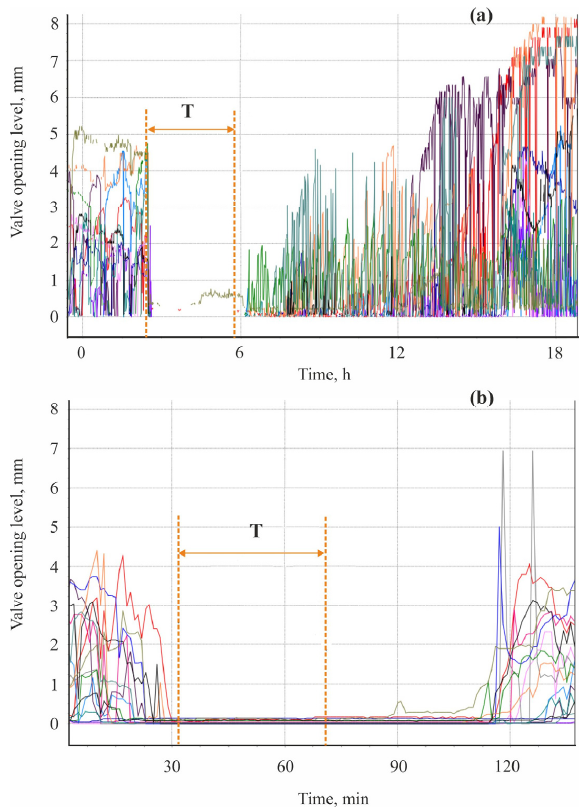
Figure 7. Valve activity of Black Sea mussels Mytilus galloprovicialis from Kazachya Bay, Black Sea (adopted from [91]): ( a ) ammonia NH 4 OH (10 mg L − 1 ), ( b ) hydroquinone 1 g L − 1 . T—period of exposure. Different color lines correspond to different mussel individuals.